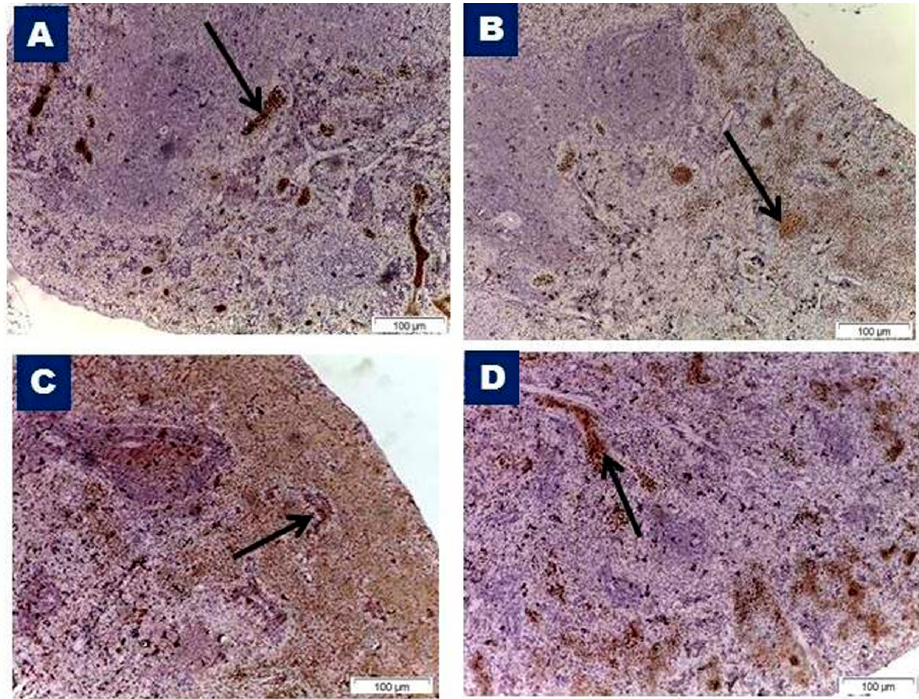
Figure 8. Photomicrographs of immunohistochemically-stained sections of the spleen with anti-vascular endothelial growth factor (VEGF) from different studied groups. ( A ) Control group, ( B ) vitamin C group showing positive brown immunoreactivity (arrows) within the red pulp, with negatively stained white pulp. ( C ) Olanzapine-treated group showing a marked increase in immunostaining within the red pulp (arrow) and negatively stained white pulp. Note, strong brown cytoplasmic staining within endothelial cells lining the venous sinuses. ( D ) Olanzapine and vitamin C group showing moderate immunostaining within the red pulp in the endothelial cells of venous sinuses (arrow) but no immunoreactivity within the white pulp. VEGF immunostaining, ×100.